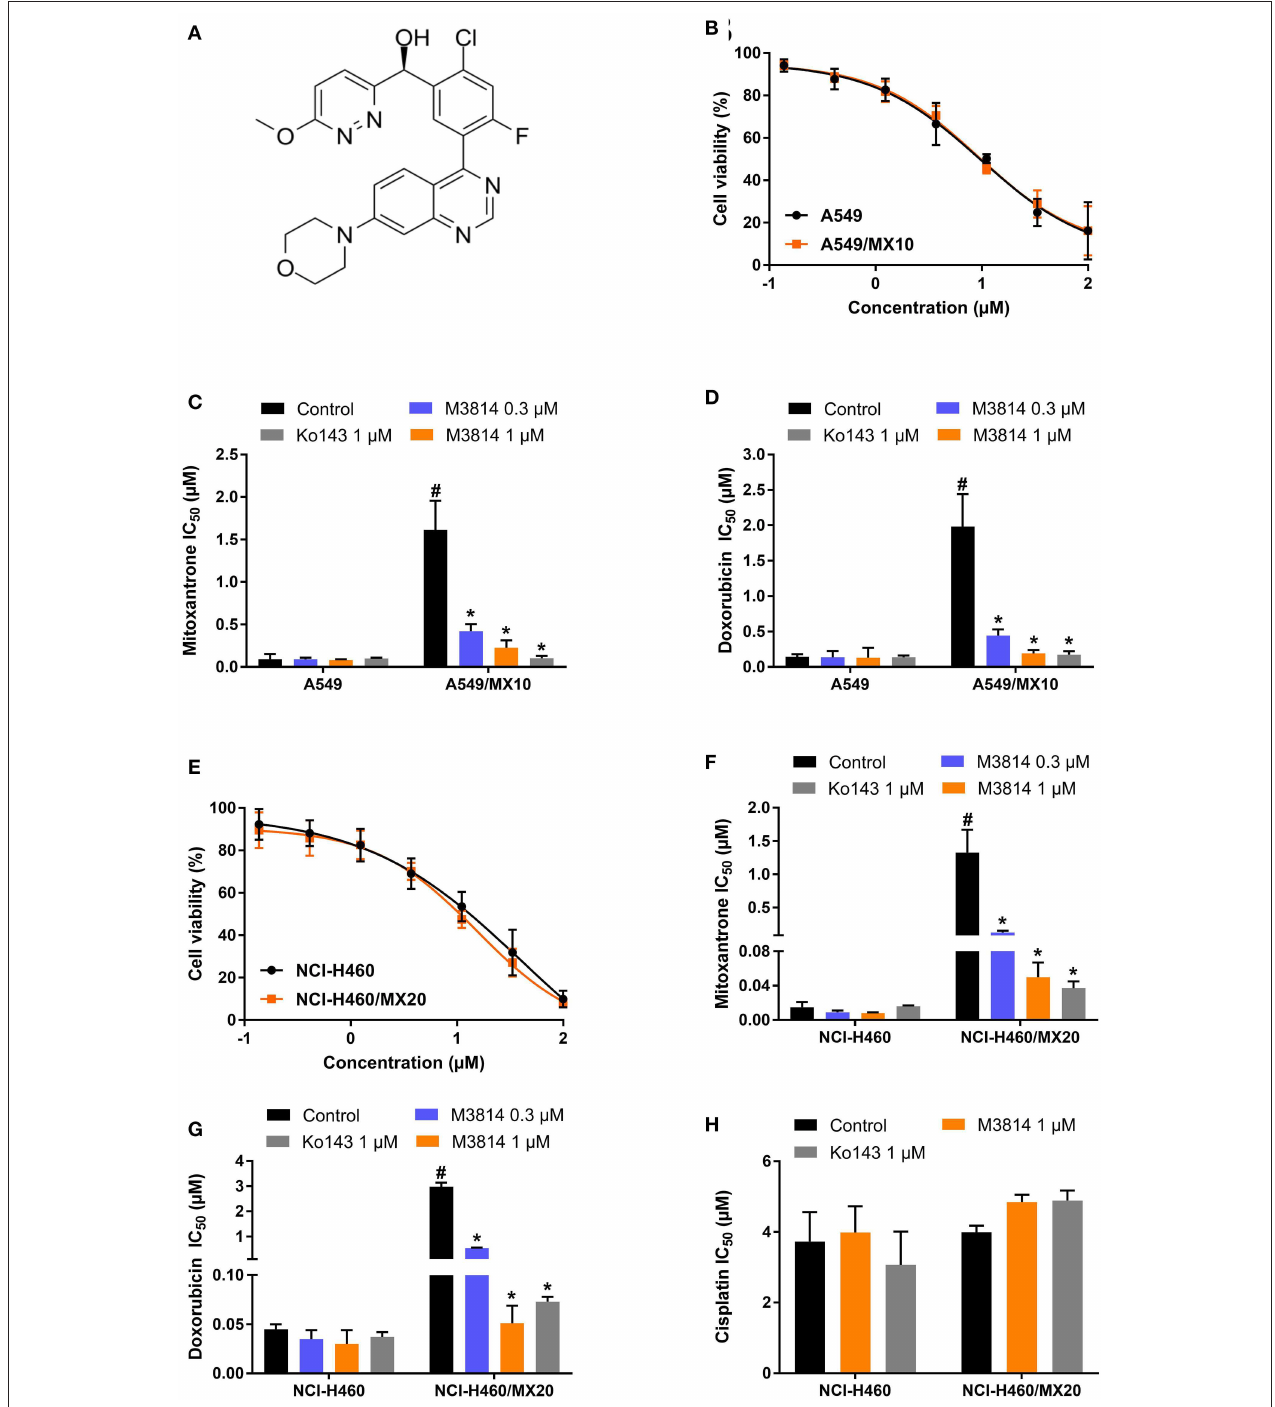
FIGURE 1 | Chemical structure and the effect of M3814 on the cytotoxicity of anticancer drugs in ABCG2-overexpressing cancer cells. (A) Chemical structure of M3814; (B) Cell viability curves for A549 and A549/MX10 cells; The effect of M3814 on the cytotoxicity of mitoxantrone (C) , doxorubicin (D) in A549 and A549/MX10 cells; (E) Cell viability curves for NCI-H460 and NCI-H460/MX20 cells; The effect of M3814 on the cytotoxicity of mitoxantrone (F) , doxorubicin (G) , and cisplatin (H) in NCI-H460 and NCI-H460/MX20 cells. Data are expressed as mean ± SD from a representative of three independent experiments. * p < 0.05 vs. the control group, # p < 0.05 vs. the control group in parental cell lines.